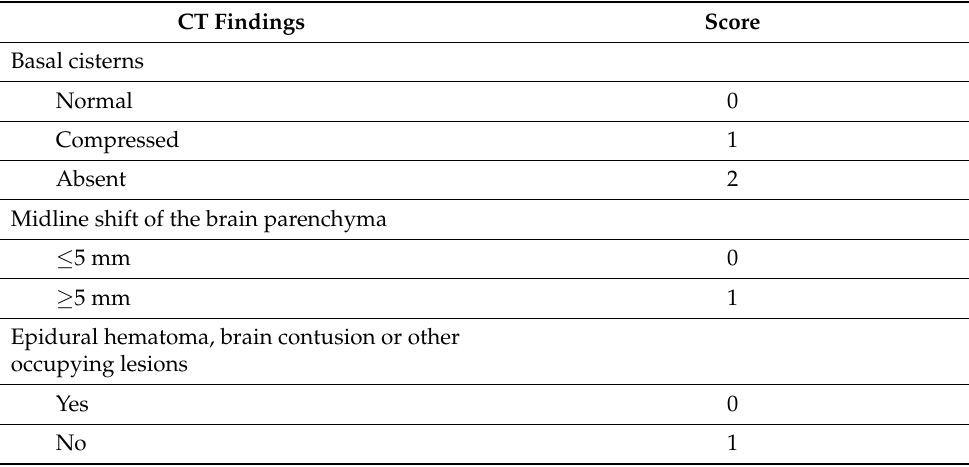
Table 1. Rotterdam computed tomography